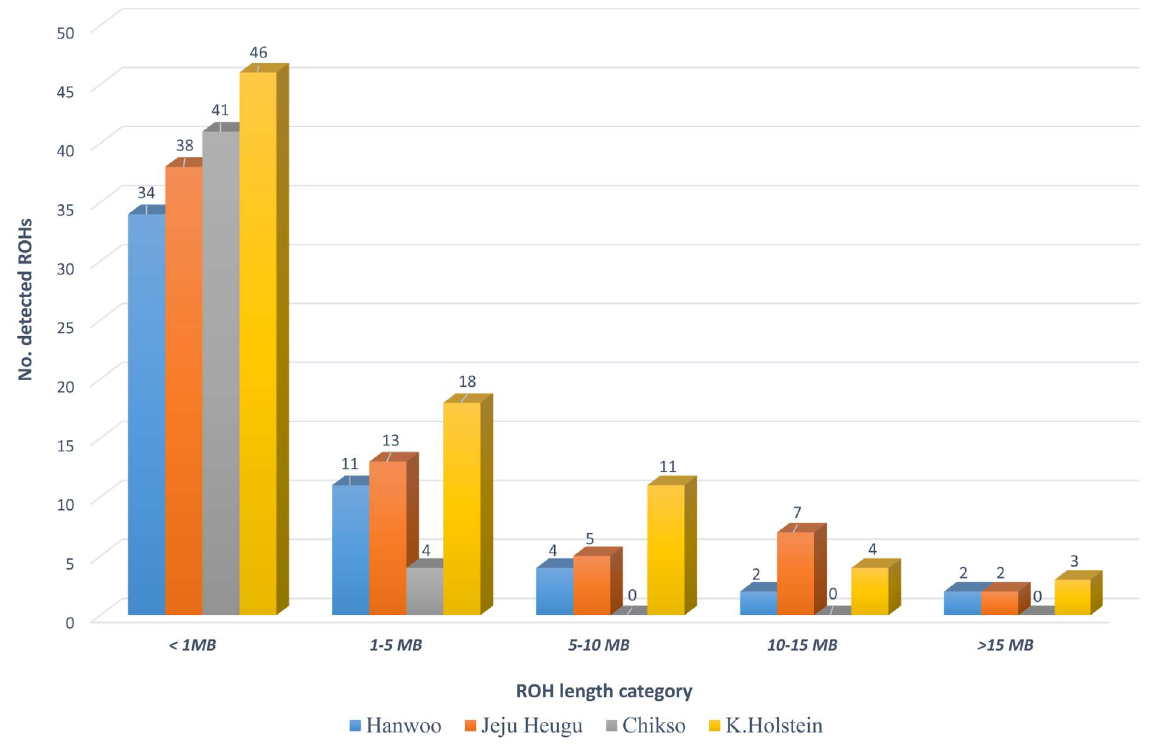
Figure 6. The size distribution of runs of homozygosity (ROHs). The total ROHs in each breed were plotted with respect to the five size categories ( , 1 MB, 1–5 MB, 5–10 MB, 10–15 MB, and . 15 MB). Breeds from left to right in each size category are Hanwoo, Jeju Heugu, Chikso, and Korean Holstein, which are also highlighted with different colors corresponding to the legend in this figure.